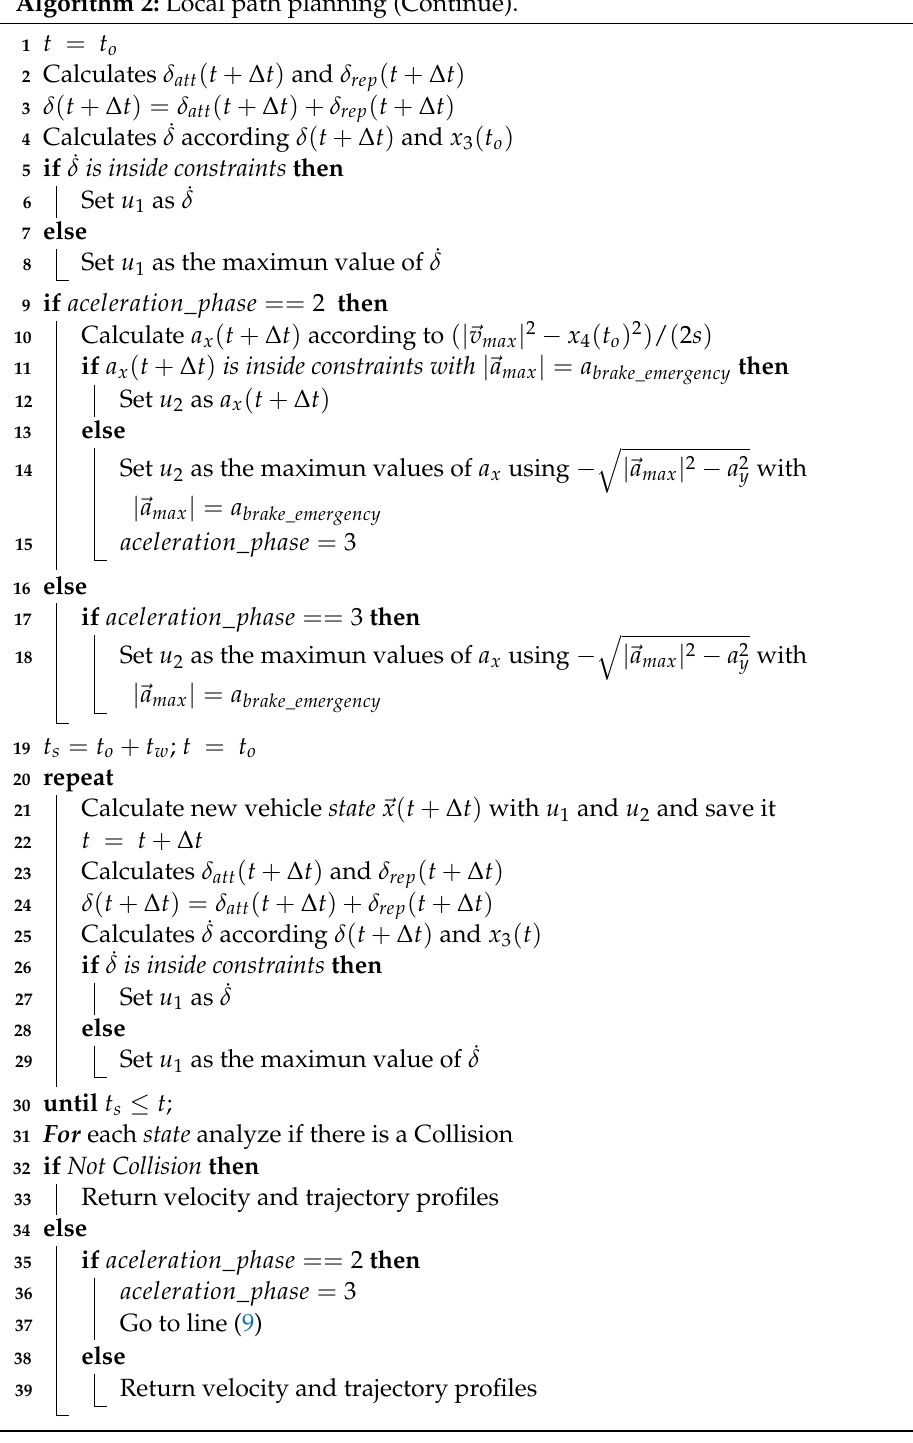
Algorithm 2: Local path planning